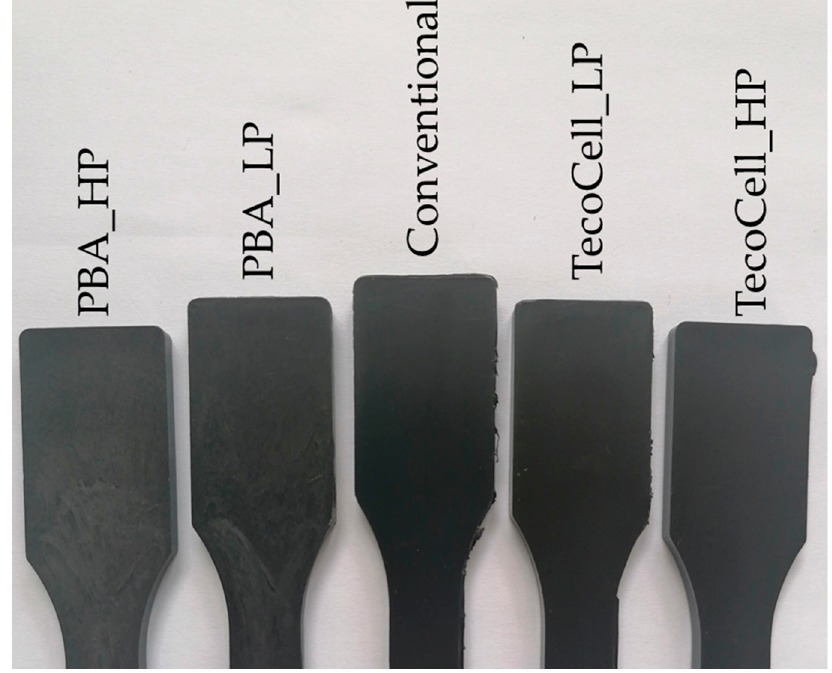
Figure 9. Visual comparison between the conventional, PBA and CBA parts.